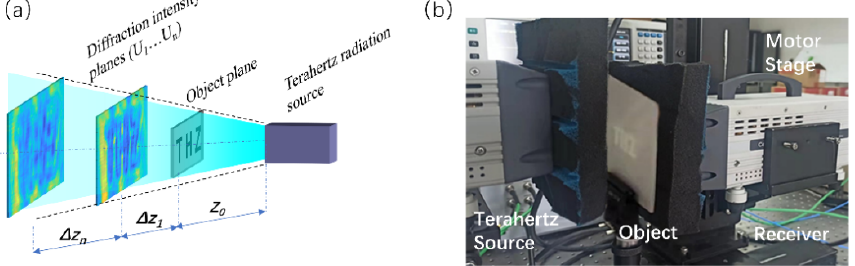
Figure 5. Terahertz lensless phase retrieval diagram ( a ) and experiment setup ( b ).